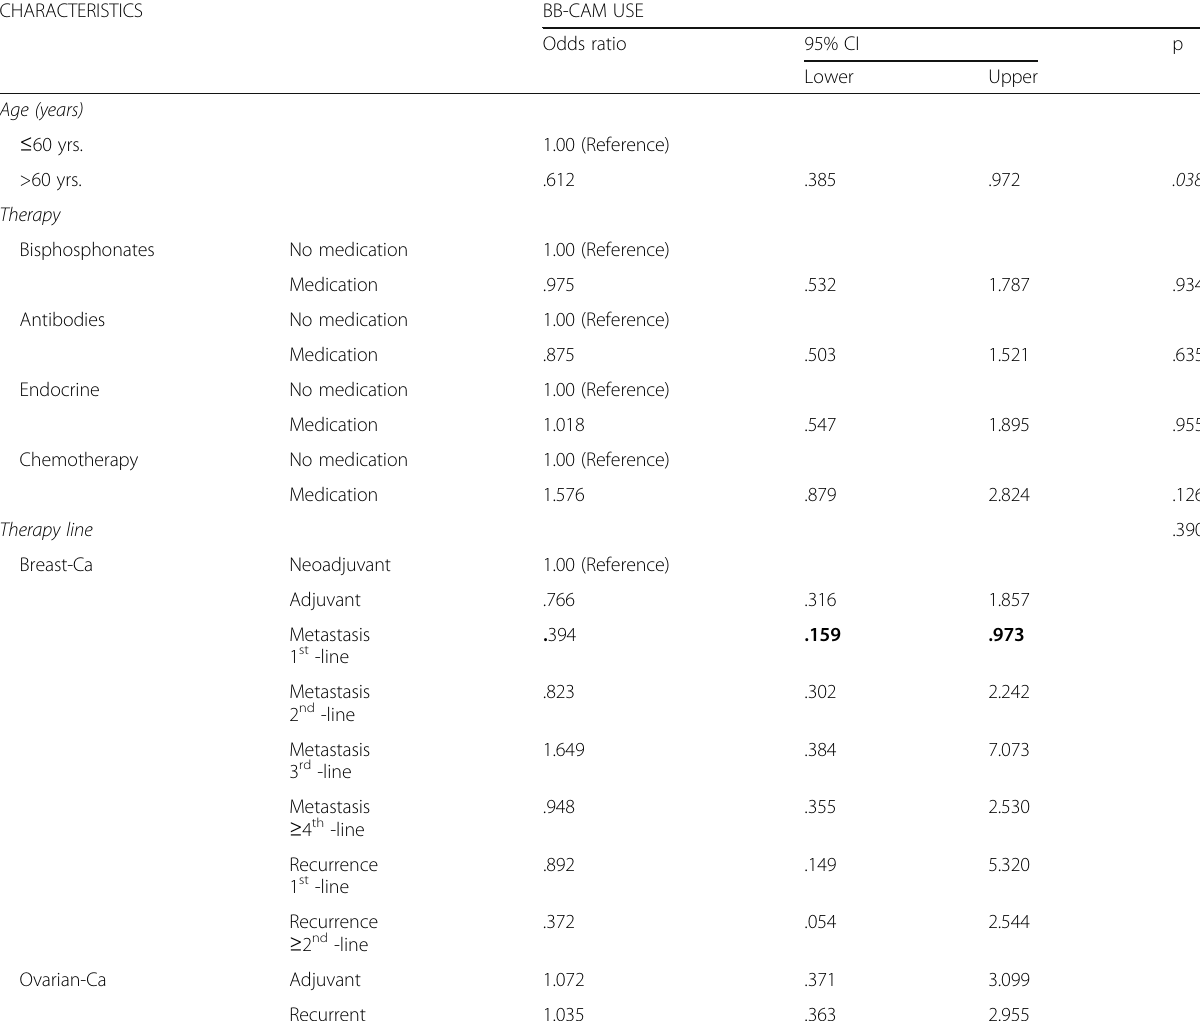
Table 3 Bivariate logistic regression model with odds of use of BB-CAM, adjusted for selected patients´ characteristics